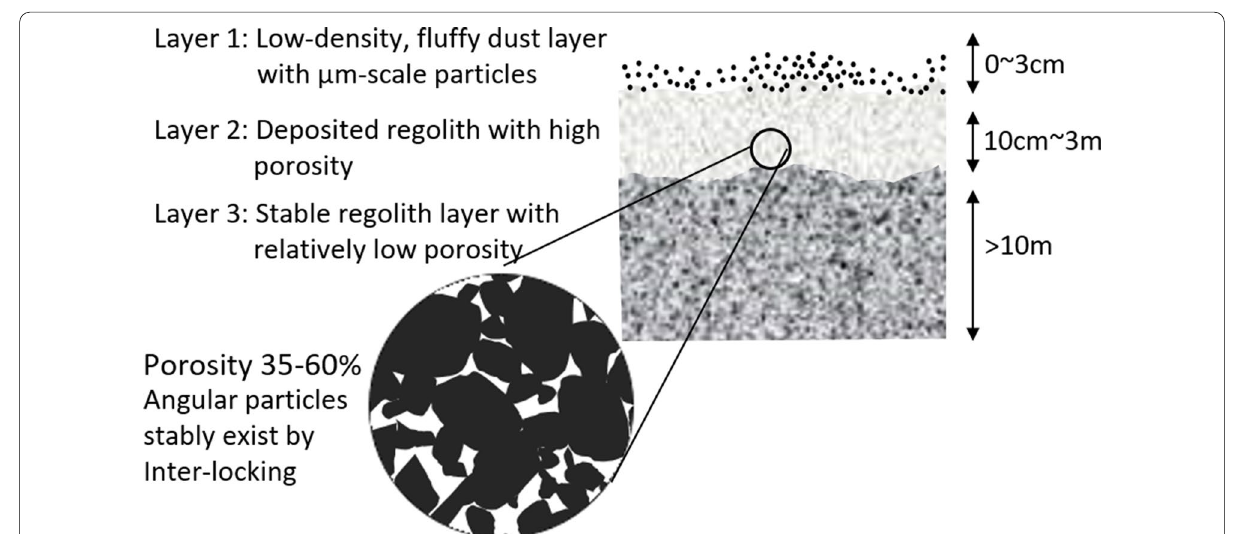
Fig. 3 Estimated surface and subsurface